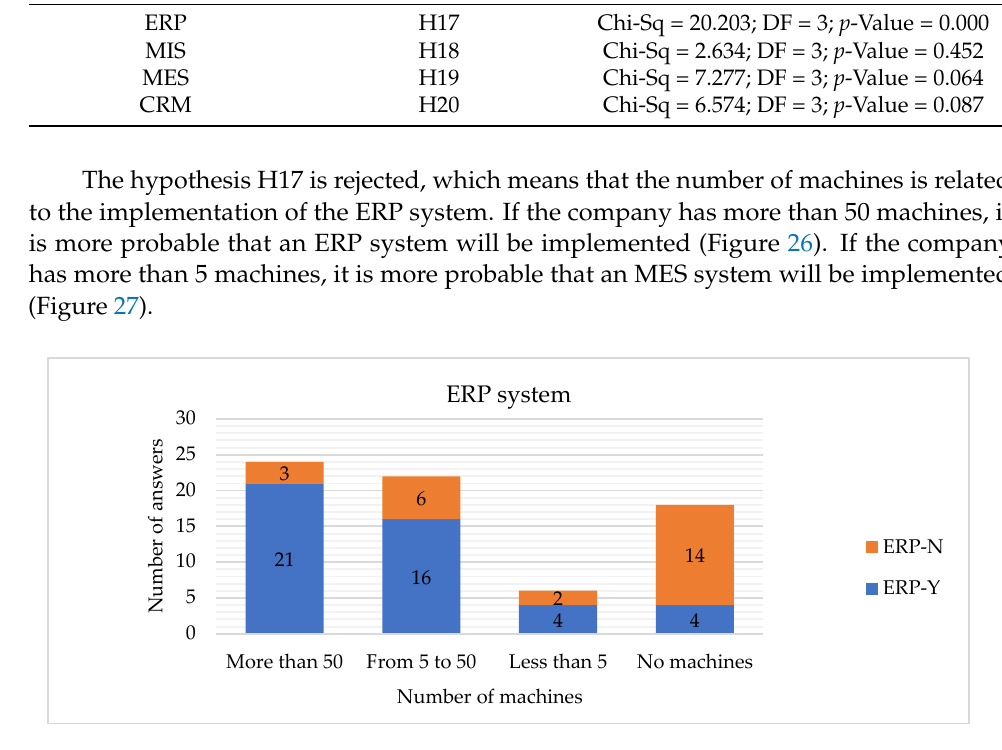
Figure 26. Number of companies having ERP system implemented (ERP-Y) or not (ERP-N) by number of machines.